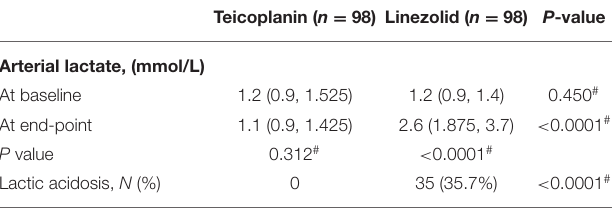
TABLE 2 | Arterial lactate at baseline and the end-point of patients. Teicoplanin ( n = 98) Linezolid ( n = 98) P -value Arterial lactate,